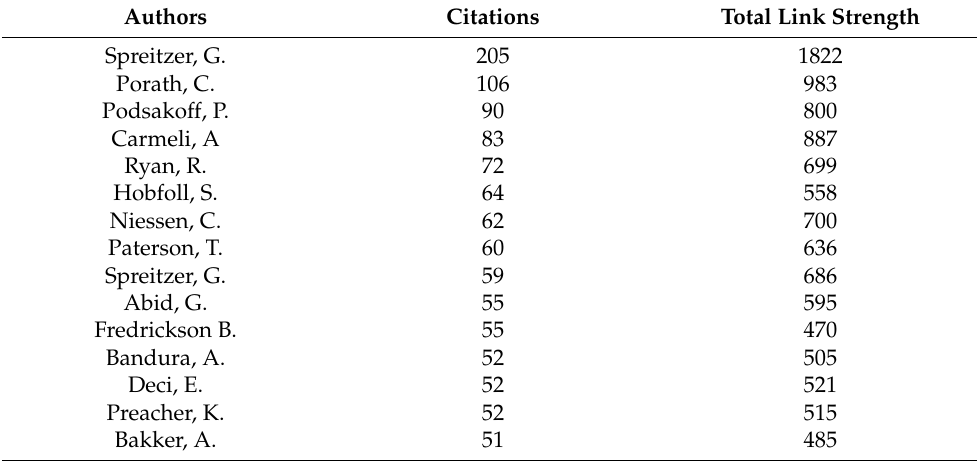
Table 7. Co-citation of cited authors and total link